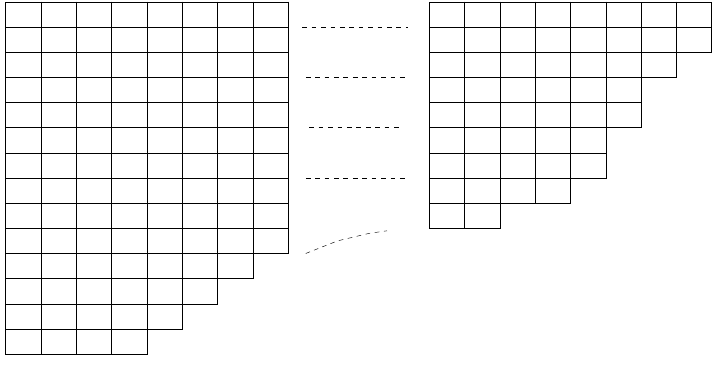
Figure 3 . A typical Young diagram for one-gap